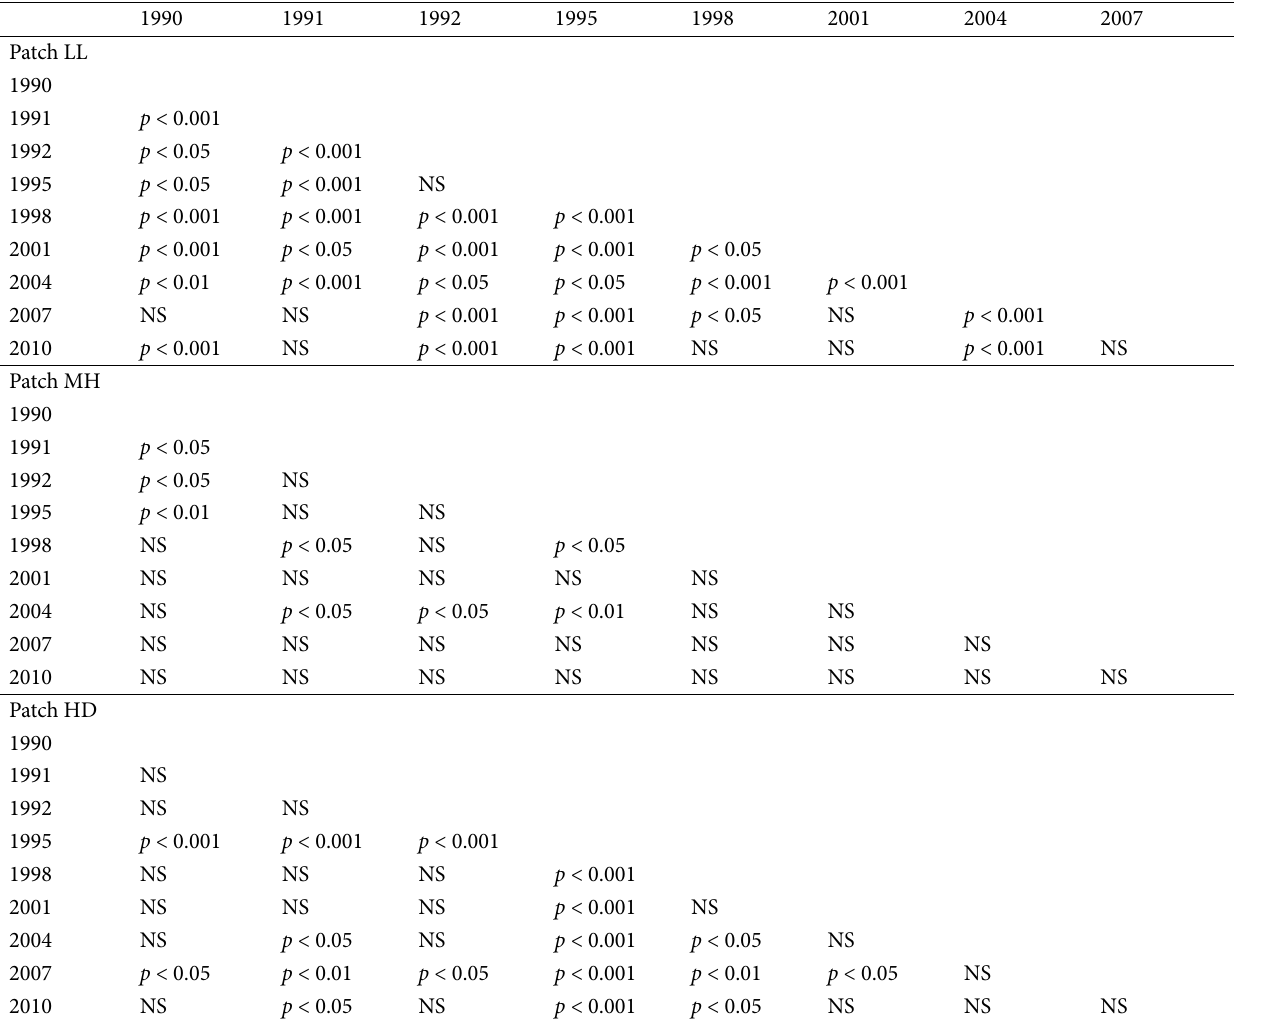
Table 4 The significance of differences in the percentage of generative ramets in the study patches of the Senecio umbrosus population; data analyzed with the u